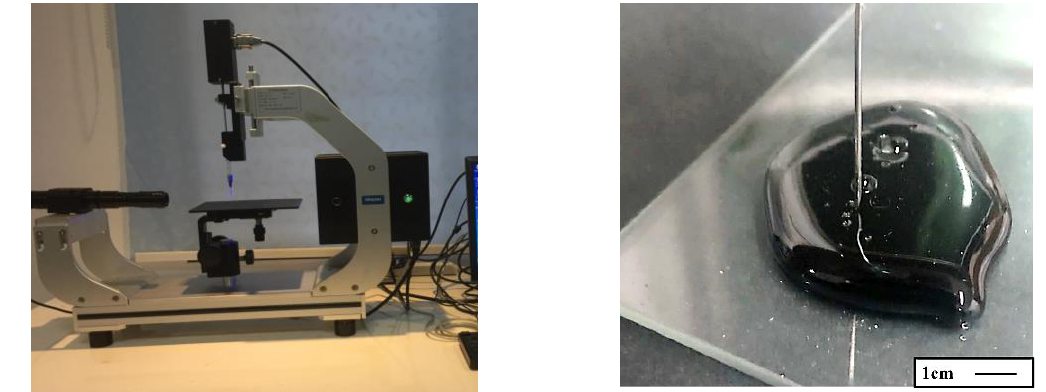
Figure 15. Contact angle test.